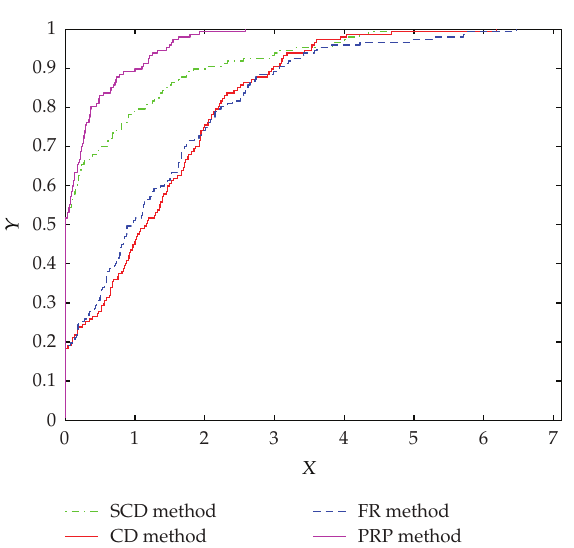
Figure 2: Performance profiles of the given methods with respect to the number of